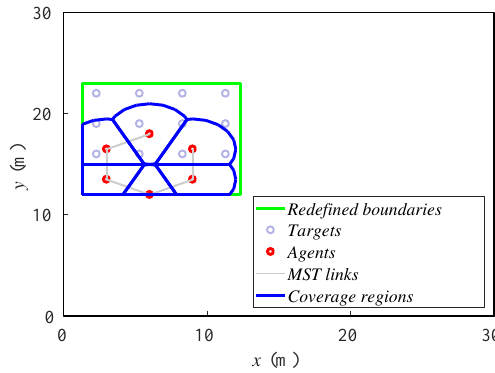
Figure 5. Initial positions of agents and targets.